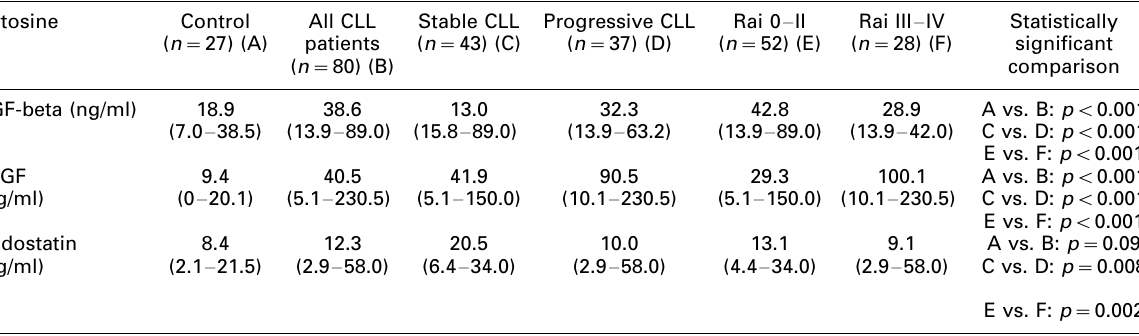
Table 2. Comparison of serum levels of TGF b 1, bFGF and endostatin in the healthy control group and in 80 untreated B-cell CLL patients All CLL Cytosine Control (n (cid:4) / 27) (A)